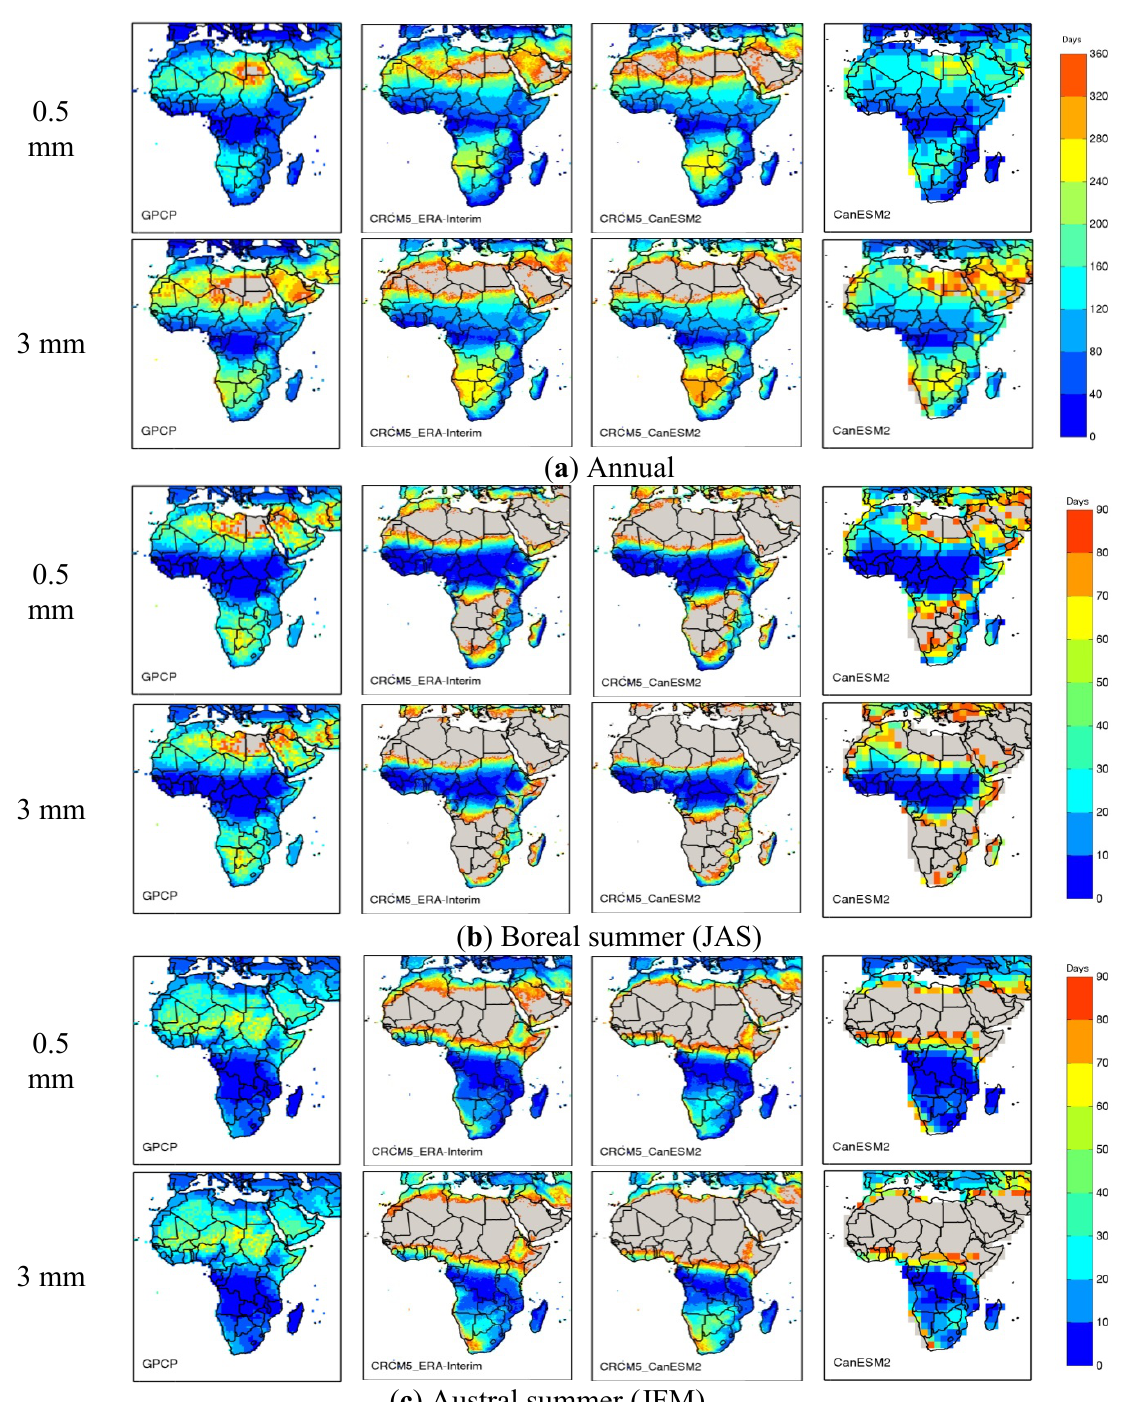
Figure 4. Same as Figure 2, but for the five-year return levels of the maximum dry spell duration. The grid points are masked in grey color where the return levels are larger than 365 days in the case of ( a ), and 93 days for the cases of ( b ) and ( c ).